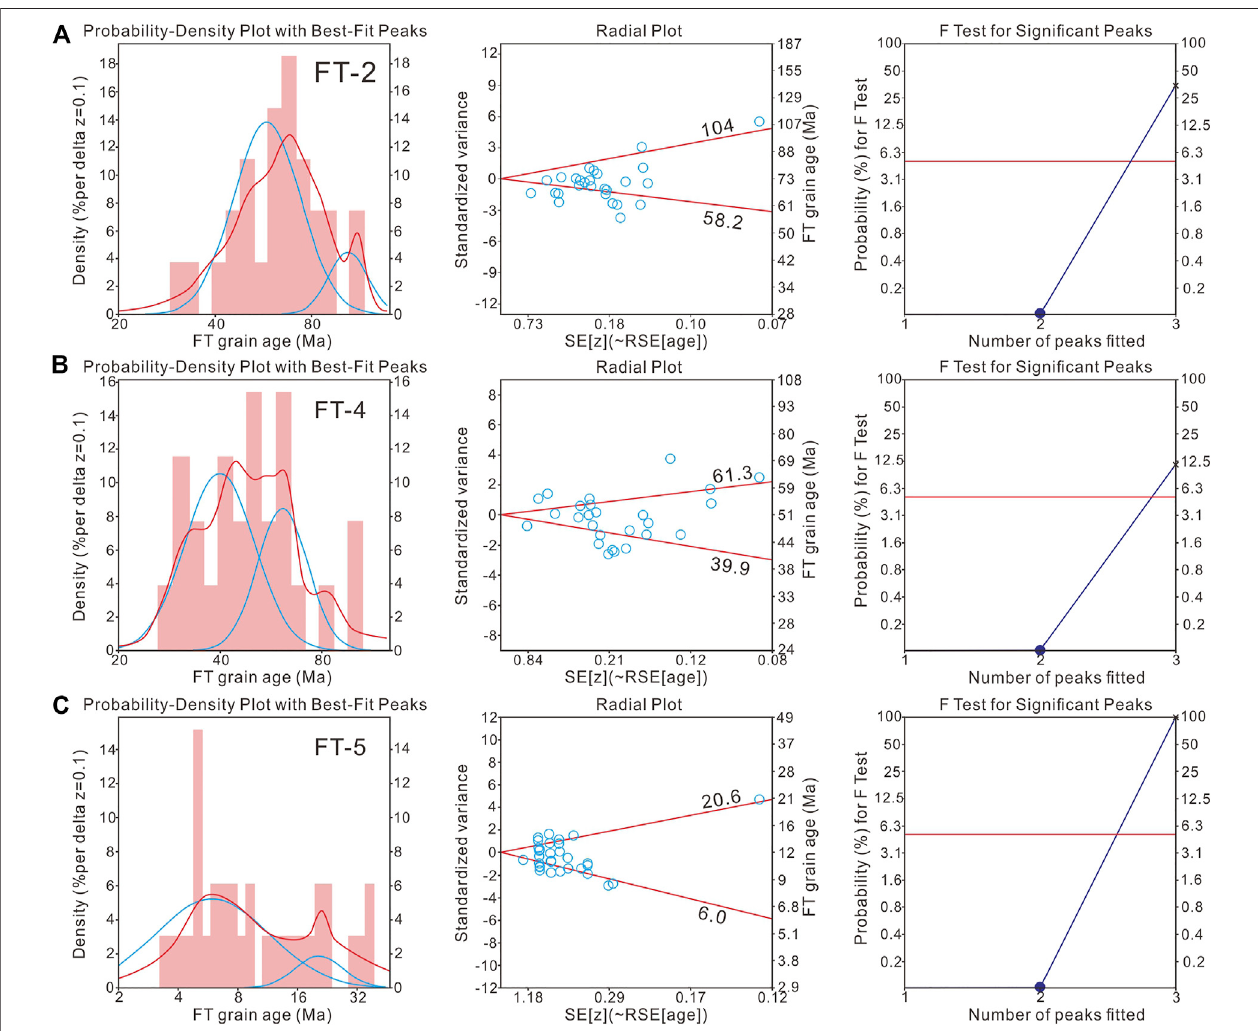
FIGURE5 | Decomposition results of apatite fi ssion track center age of the sample. The left picture shows the single-particle age distribution histogram, in which the red line is the fi tting curve of the single-particle age histogram, and the blue line is the fi tting curve of the two age-groups after decomposition. The middle picture is a single-particle age radar chart, in which the red line is the age of the decomposed age-group. The right picture is the P (F) test chart.